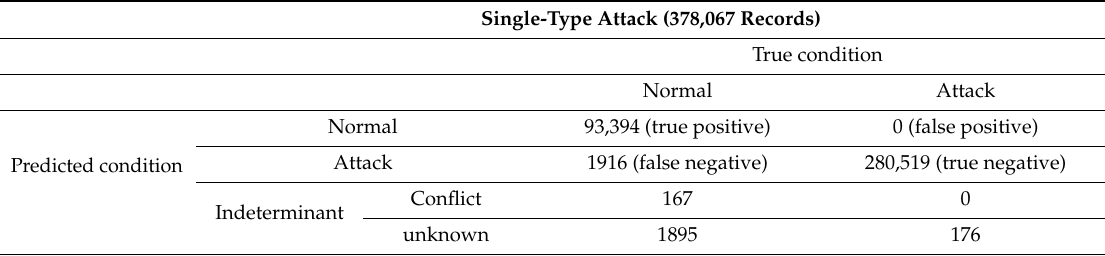
Table 8. Detection performance for single-type attacks.